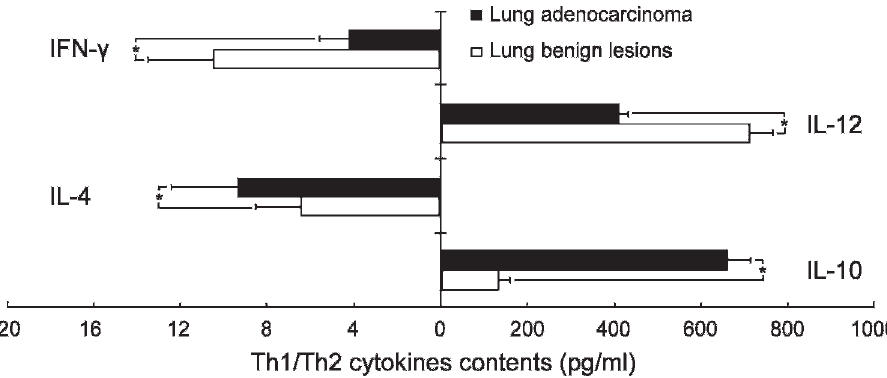
Figure 1 - Th1/Th2 cytokine expression in fresh lung adenocarcinoma tissue and benign lung lesion homogenates (pg/ml). Fresh lung adenocarcinoma homogenates contained significantly more IL-4 and IL-10 than benign lung lesion homogenates. * p ,